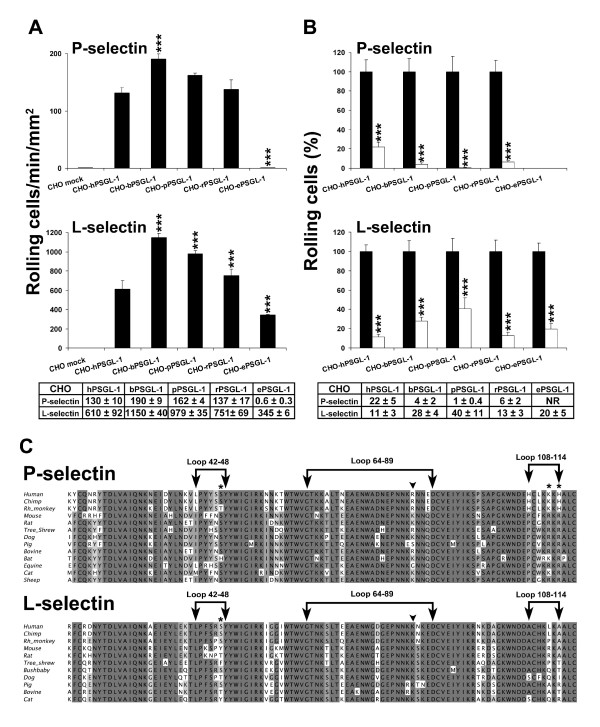
Rolling of CHO cells expressing human, bovine, pig, rat or equine PSGL-1 on L- or P-selectin. (A) CHO-PSGL-1 cells were perfused under constant shear stress (1.5 dynes/cm2) on recombinant human P-selectin or at 1.0 dyne/cm2 on human L-selectin/μ chimera adsorbed on a coverslip, precoated with goat anti-human IgM antibody, and bound to the bottom of the flow chamber. Cell recruitment was analyzed by videomicroscopy at 4–5 min of perfusion. Results represent the mean ± SEM of 3–5 experiments (***, P < 0.001; NR: no rolling). (B) Impact of sulfation on PSGL-1-dependent rolling. Control (black columns) and desulfated CHO cells (white columns) were pretreated with proteinase K. Desulfated cells were cultured for 72 h in MEMα medium containing 60 mM sodium chlorate and exposed for 60 min to arylsulfatase. Results are expressed as mean percentage of rolling cells ± SEM of 3 experiments (***, P < 0.001). (C) Amino acid sequence alignments of mammalian homologues of P- and L-selectin lectin domains. Homologues of human residues [16, 18] interacting with sulfated Tyr-48 or -51 are respectively indicated by asterisks or arrowheads. The percentages of identity between aligned sequences are grey shaded (dark grey: > 80%, grey: > 60% and light grey: > 40%).